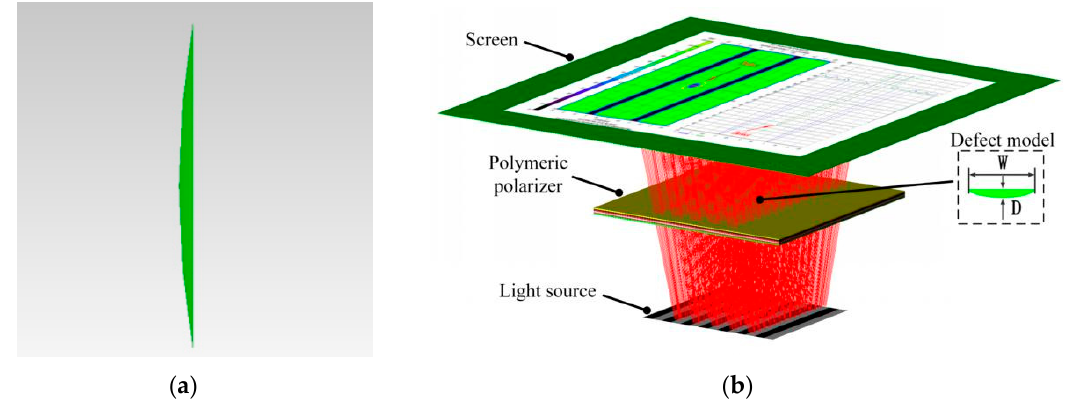
Figure 1. Defect model and TracePro simulation model. ( a ) Microscale planoconvex lens model, and ( b ) TracePro simulation model.